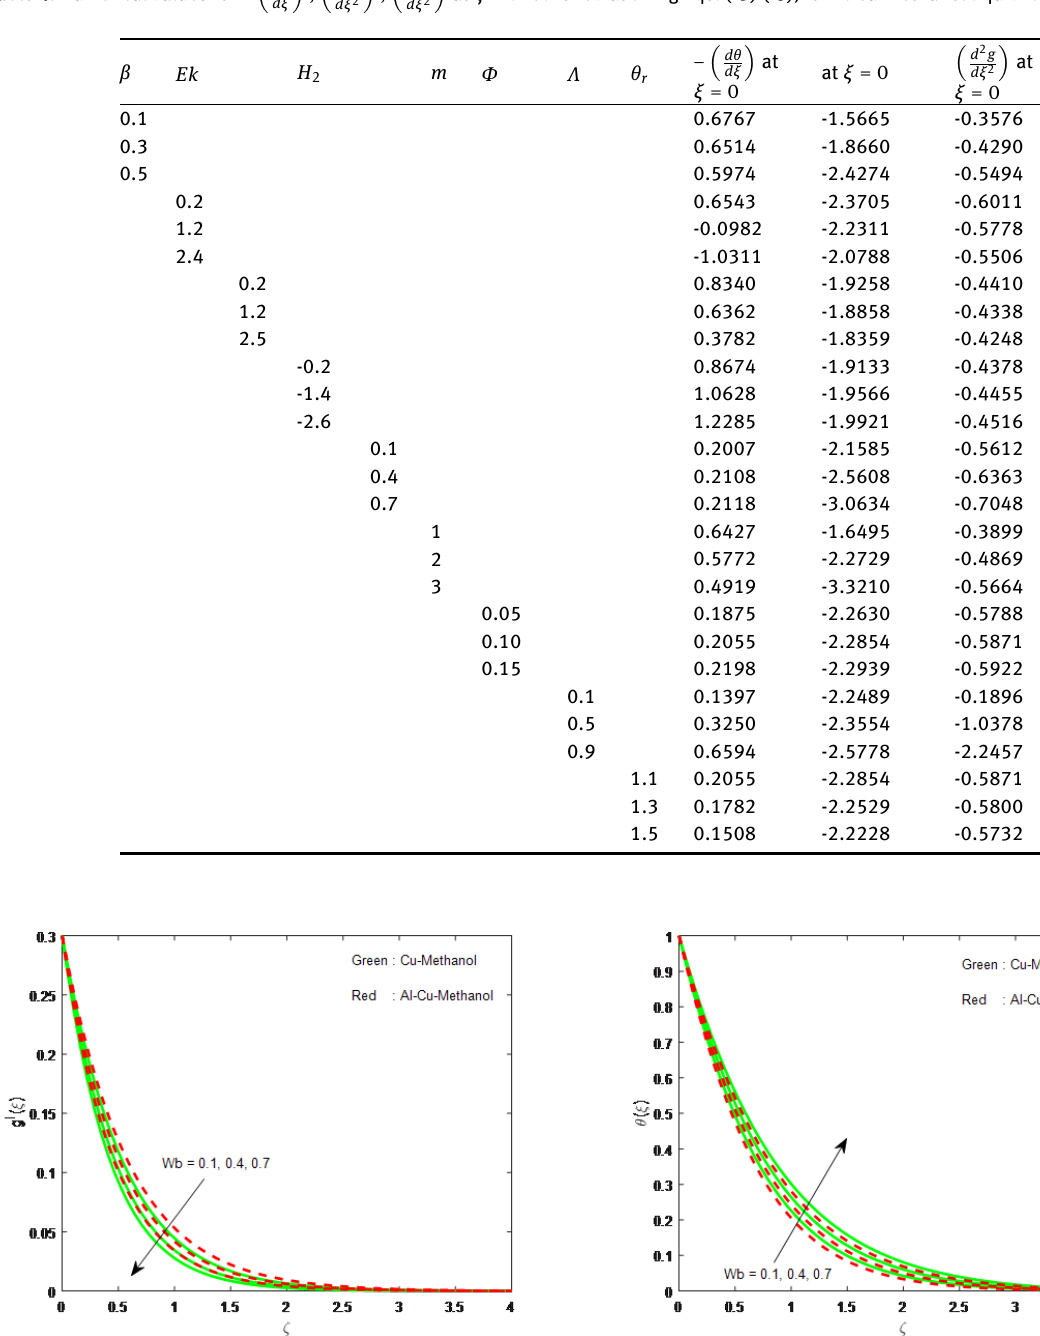
Table 4: Numerical values for −